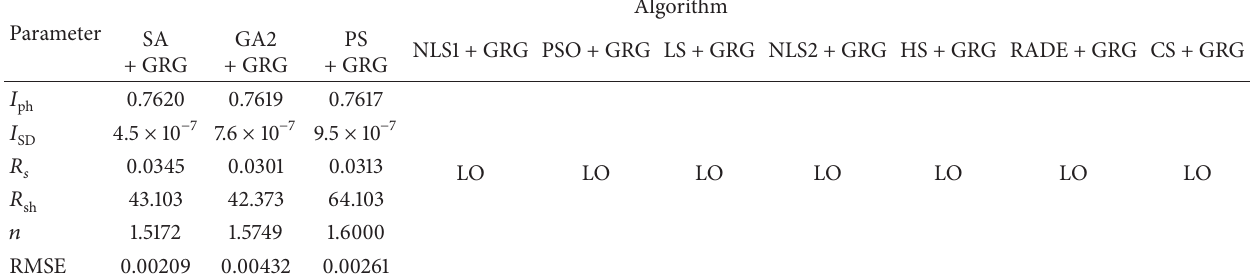
Table 3: Optimal parameter values from memetic algorithms.